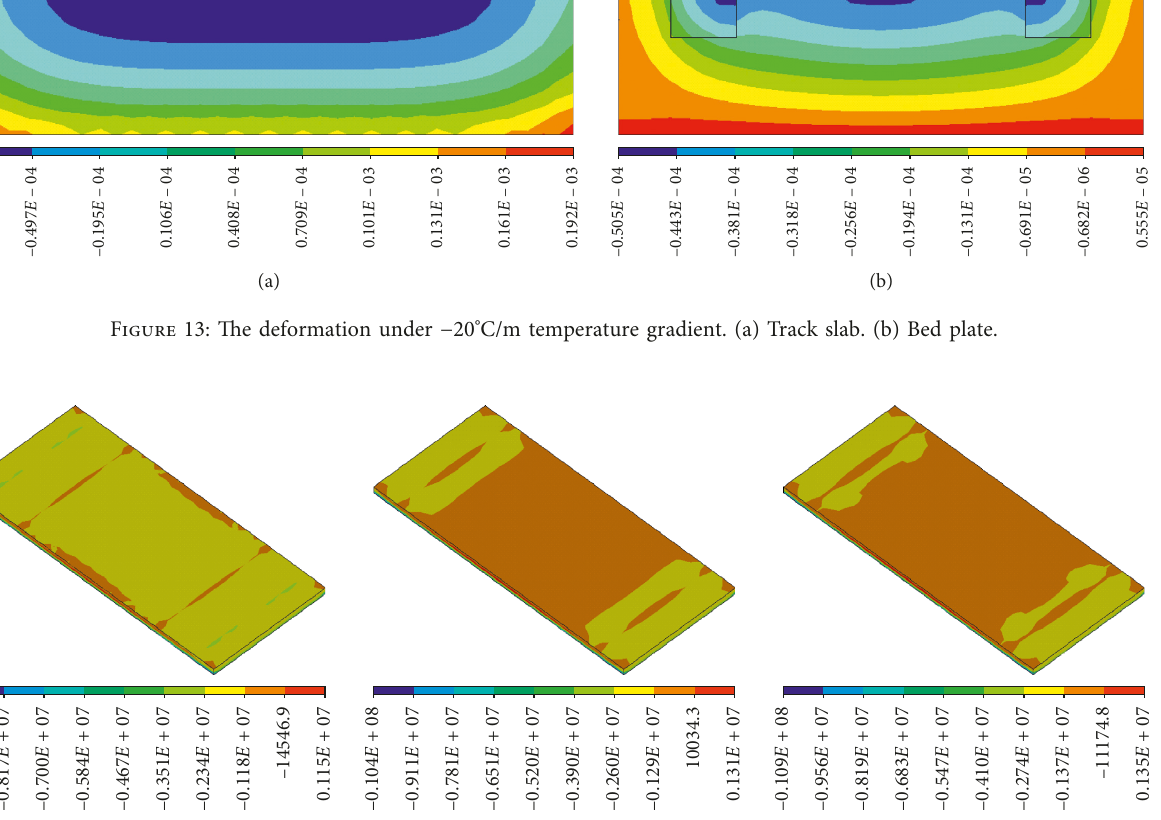
Figure 14: Longitudinal stress of the self-compacting concrete layer under condition 1. (a) P